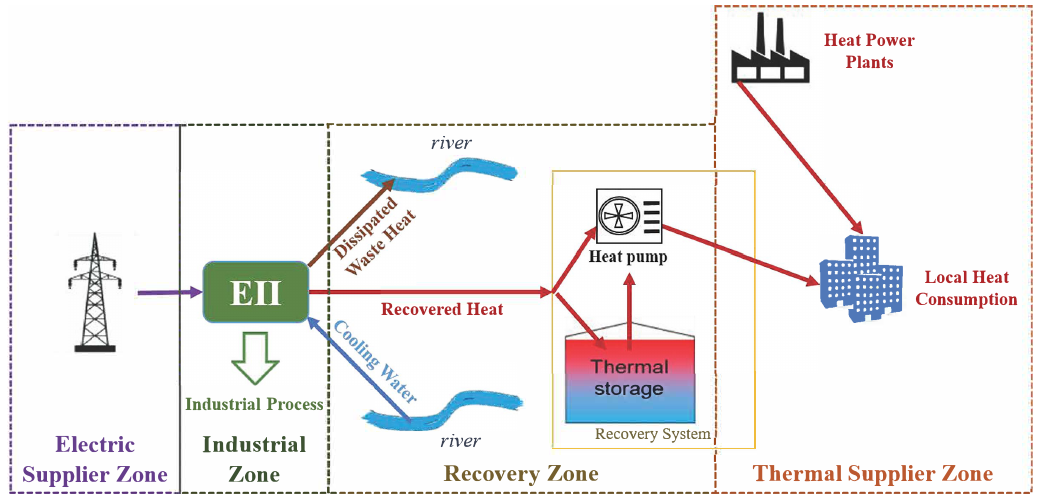
Figure 6. Thermal scheme of the waste heat recovery use